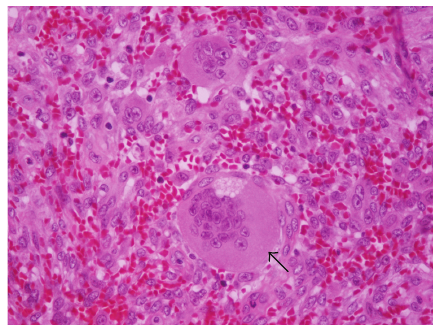
Figure 4: Histologic section of the tumor (Hematoxylin-Eosin × 400). Giant, multinucleated cells, lacking atypia or mitotic activity are present. The arrow points to one of these cells. Giant cells are disposed isolated or in small nests in abundant stroma. This is composed of spindle-shaped cells (some with storiform disposition, also lacking atypia or mitotic activity) and extravasated